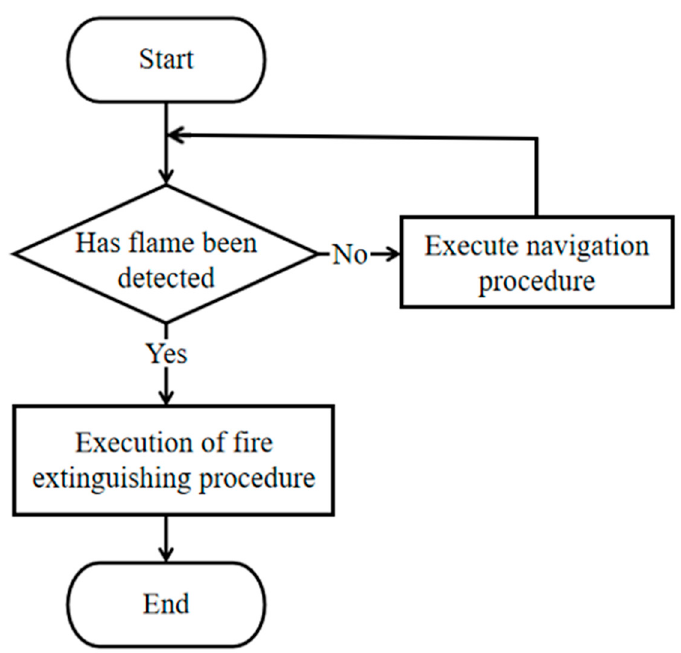
Figure A1. The chart of program logic flow.